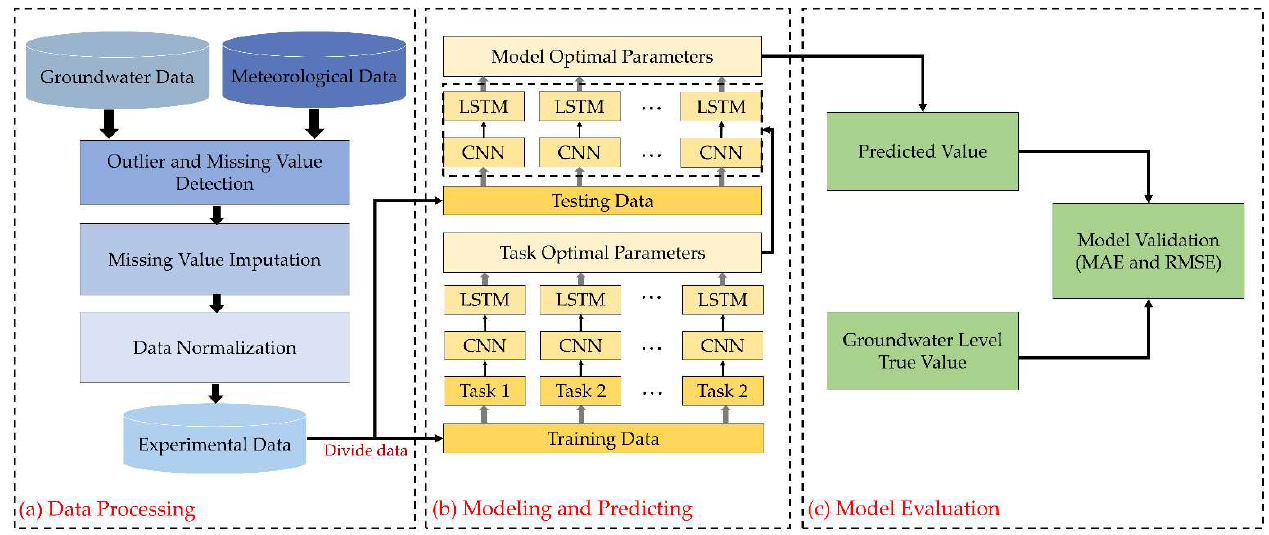
Figure 1. Groundwater level prediction process.